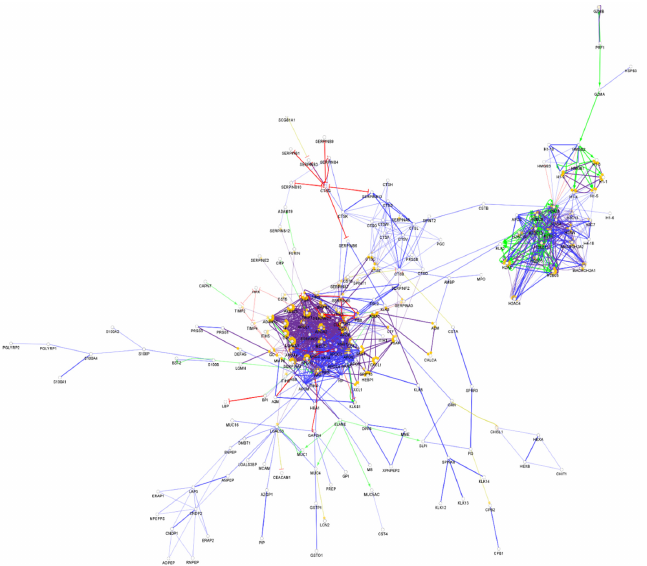
Figure 1. Partial network view of the interaction network of the chemical barrier proteins in serum. Each circle represents a protein and the lines indicate interactions. The lines with an arrow represent activation, blocking lines represent inhibition, and simple lines represent protein–protein interac- tion. Line color indicates the type of interaction: green color refers to activation, red color to inhibi- tion, blue color to binding, yellow color to co-expression, and purple color to catalysis. The proteins are labeled with their gene name. The high resolution and complete network image of this network is presented in Figure S1. Currently, more than 1800 proteins have been identified in tears by state-of-the-art proteomics techniques [109]. The major tear proteins, such as lysozyme-C, prolactin-in- ducible protein, lactotransferrin, and lacritin, have antimicrobial activity; therefore, they are involved in the defense against pathogens [5]. While many of the tear proteins are produced by the lacrimal glands, some of them originate from epithelial cells, such as dermcidin and defensins, and there are also proteins, such as albumin, originating from the blood [110]. The examination of the tear proteome revealed 200 proteins secreted to the surface of the eye and building the chemical barrier against pathogens (Table S2). Overall, 97% of the AMPs found in tears are also components of the chemical barrier of the serum. Re- garding the protein–protein interaction network of the chemical barrier proteins in tears (Figure 2), we can say that there are similarities at the level of small, unrelated clusters, but in case of the tears, the majority of AMPs are organized only into one core cluster. Most of the histone-derived AMPs found in serum are missing from tears.